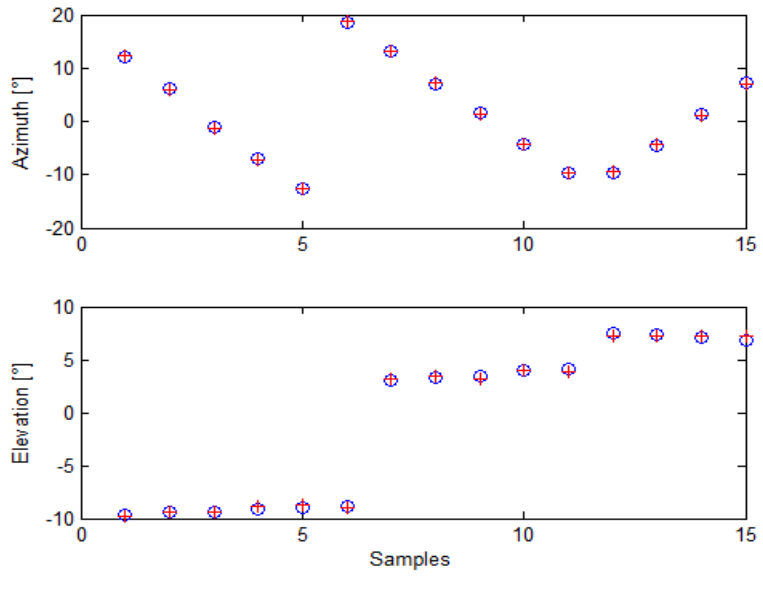
Figure 9. Target angular positions as extracted from images (blue circles) and from GPS/AHRS measurements and computed rotation matrix (red crosses) for the panchromatic camera.